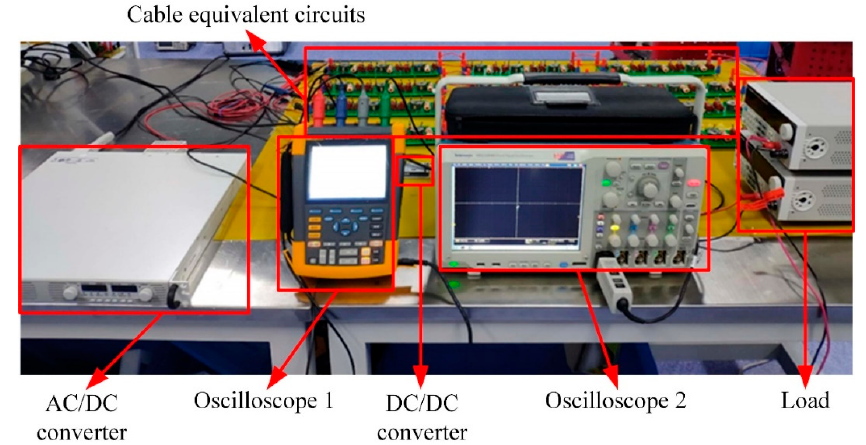
Figure6. Themedium-voltageexperimentalprototypeofasingle-nodeCSOunderseaDCpowersystem. Figure 6. The medium-voltage experimental prototype of a single-node CSO undersea DC power system.